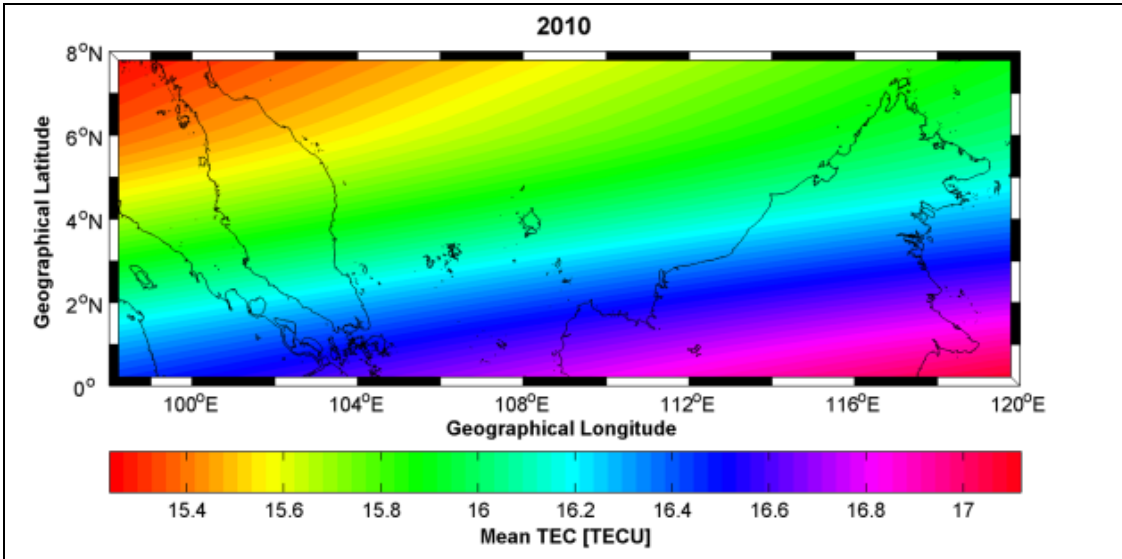
Figure 1. Two network geometries: (a) 4 reference stations with inter-station distances up to 34 km, (b) 4 reference stations with inter-station distances up to 100 km. Blue and red dots represent reference and user stations, respectively (Alves et al, 2003)